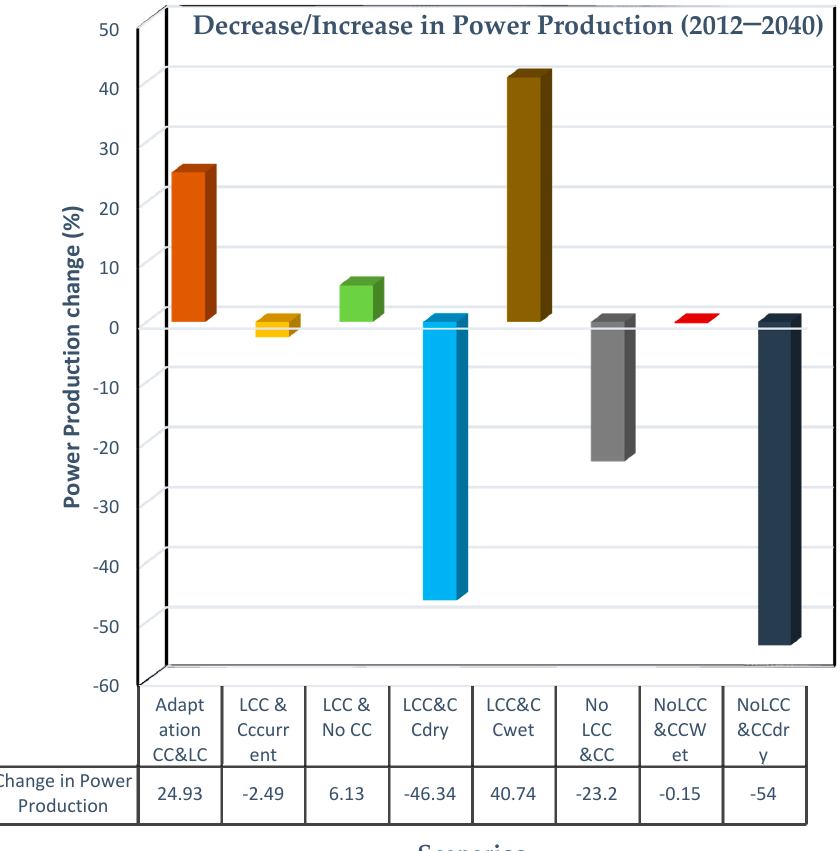
Figure 8. Change in power production.